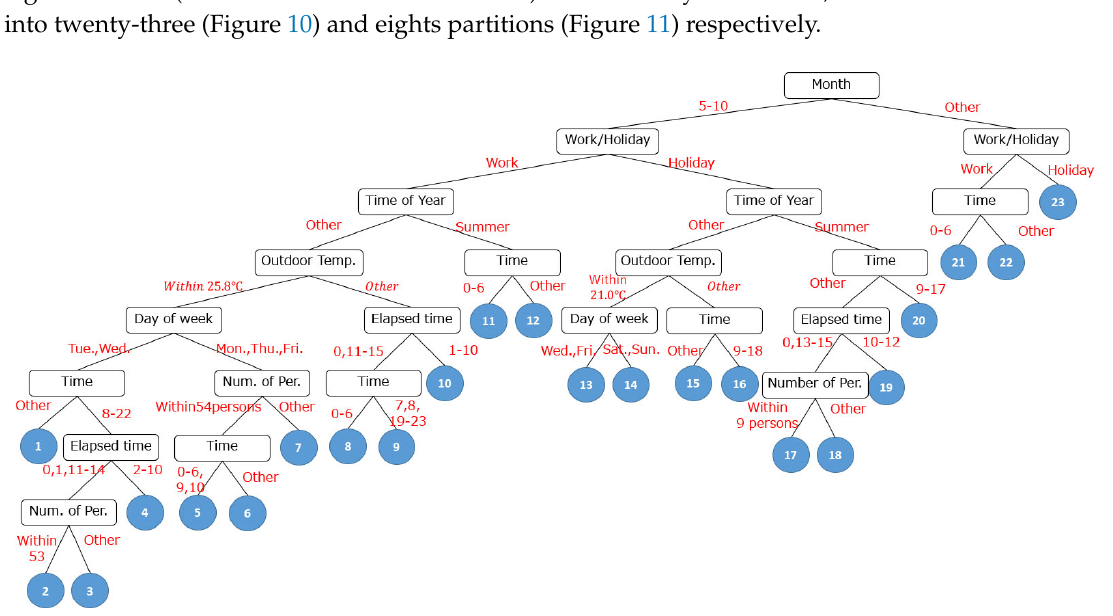
Figure 10. The prediction model for air-conditioners by the tool.